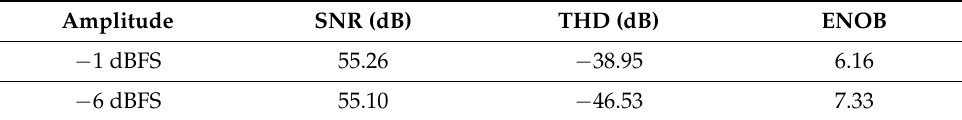
Table 1. Measured detector parameters at f in = 1.31